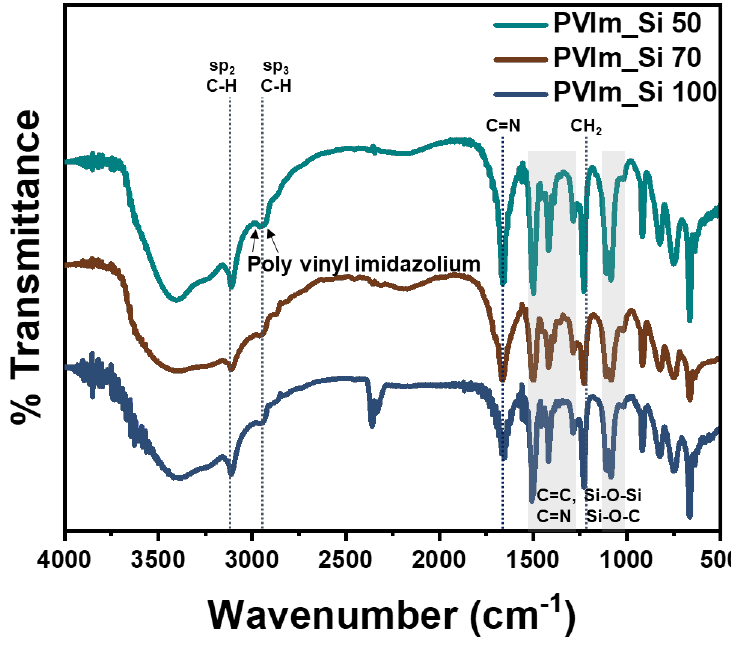
Figure 3. FT-IR spectra of PVIm_Si.